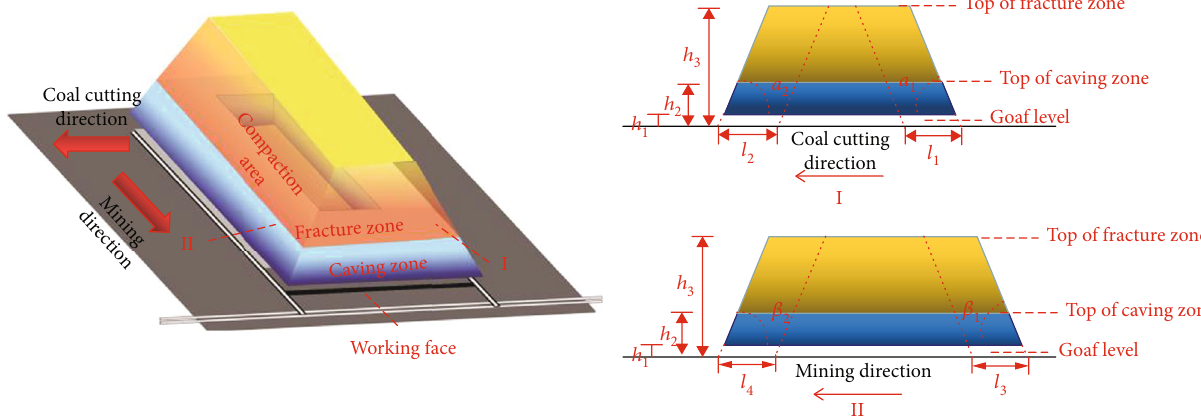
Figure 14: Distribution of the “ three zones ” of overlying strata under the in fl uence of